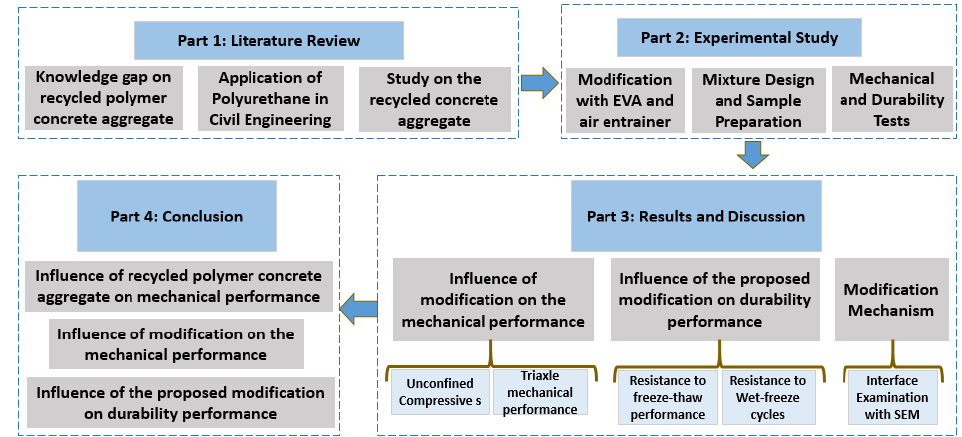
Figure 1. Demonstration for the logic structure of the whole paper.